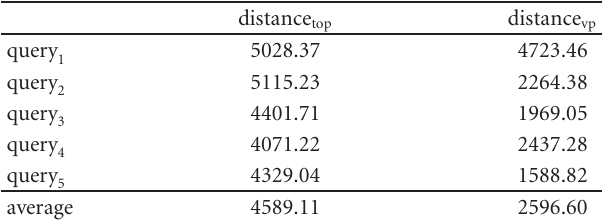
Table 6: A preliminary experimental